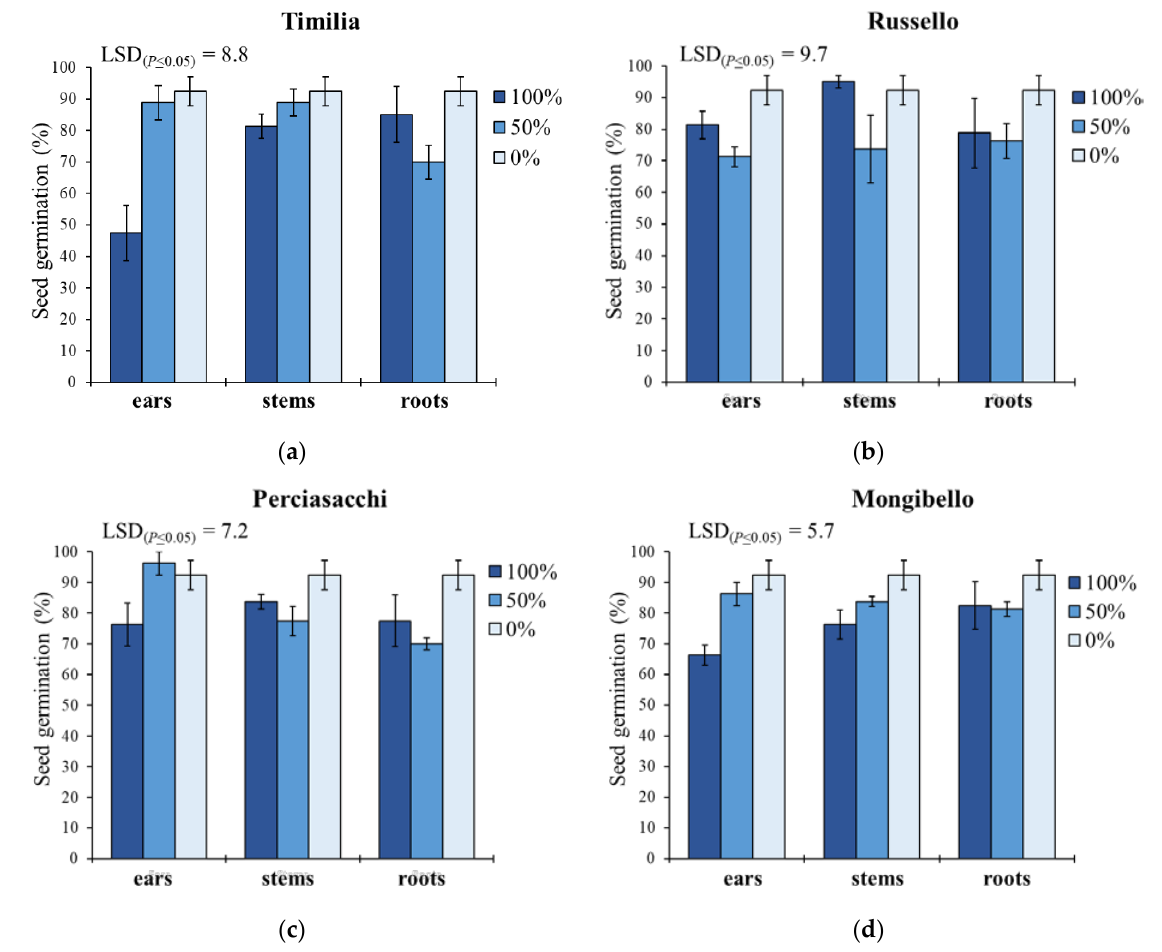
Figure 1. Seed germination percentage of Portulaca oleracea as affected by durum wheat genotype, plant part and extract dilution. ( a ) ‘Timilia’; ( b ) ‘Russello’; ( c ) ‘Perciasacchi’; ( d ) ‘Mongibello’; Least Significant Difference (LSD) interaction was calculated with the LSD test at p < 0.05. Bars indicate ± standard error.